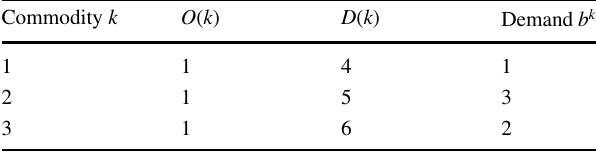
Fig. 1 Schematic representation of the network of the Example1 Table 5 The number of demands between origin and destinations Commodity k